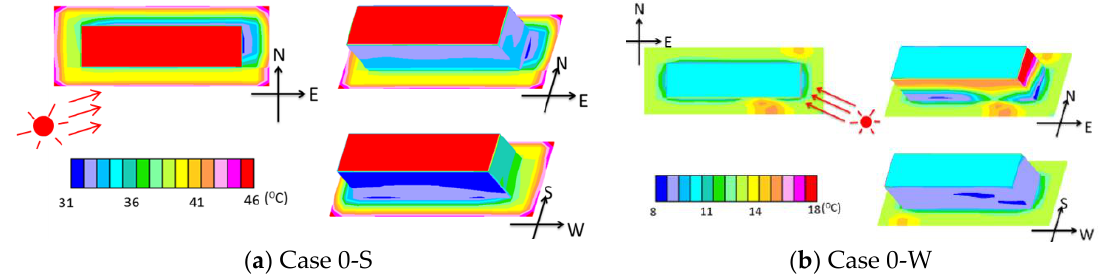
Figure 7. The surface temperatures for Case 0-S and Case 0-W.